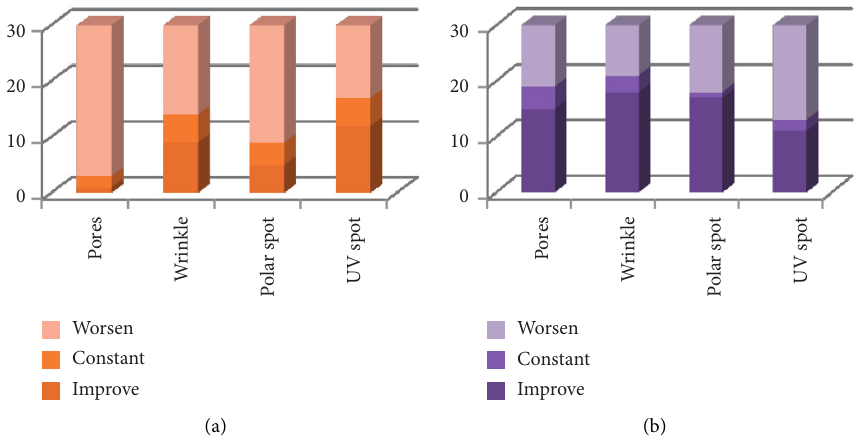
Figure 2: A comparison of the second and third observations between the control (a) and treatment (b) groups.